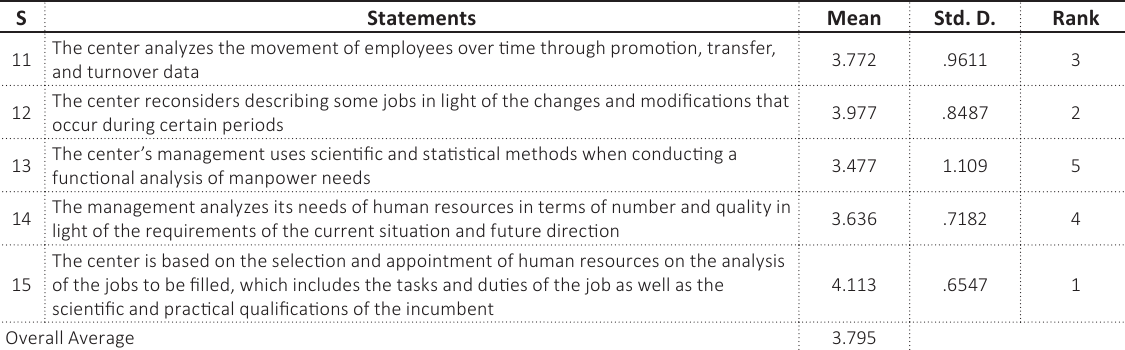
Table 3. Means and standard deviations of the labor supply analysis variable S